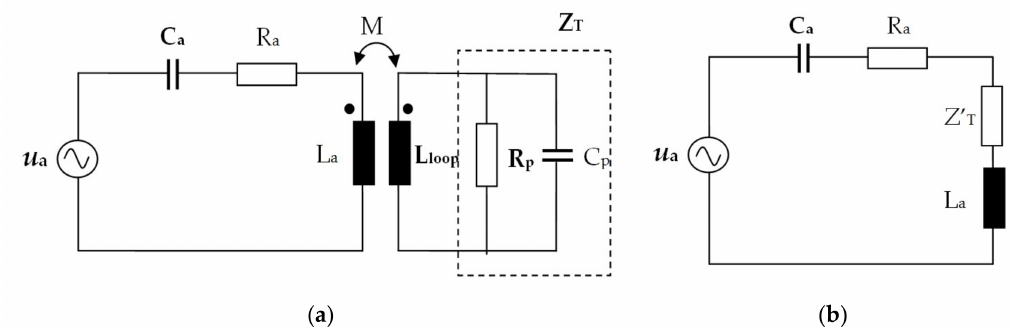
Figure 3. Electrical schemes for UHF RFID passive tag: ( a ) The circuits of antenna and transponder, inductively coupled; ( b ) the circuit of antenna with the load impedance introduced by the inductive transponder–antenna